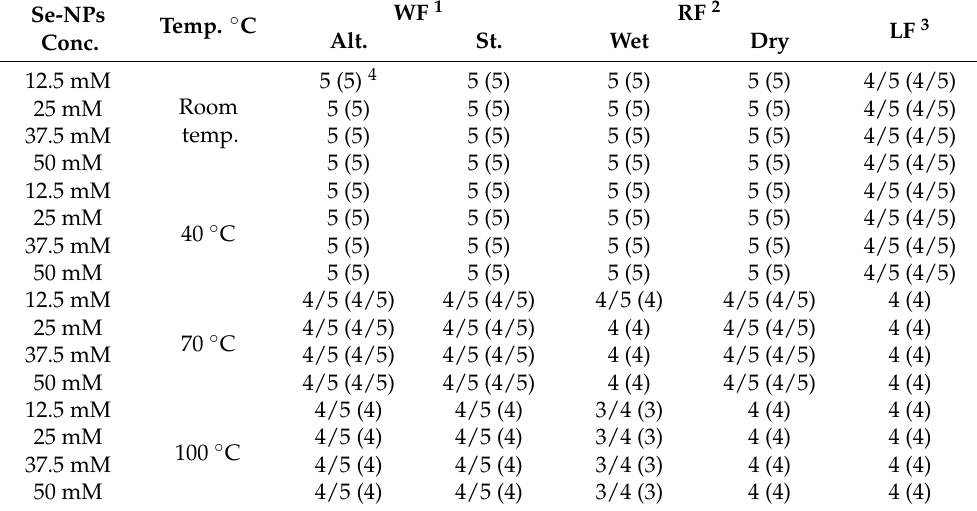
Table 4. Fastness properties of Se-dyed wool fabrics at different temperatures. Se-NPs Conc.